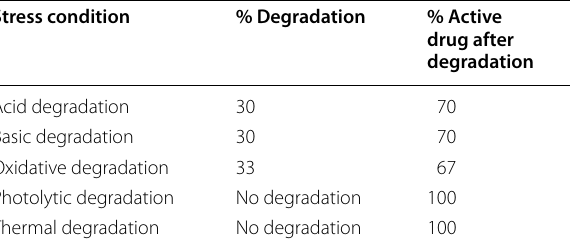
Table 7 Results of forced degradation study for empagliflozin